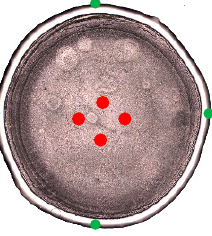
Figure 3. Illustration of the different positions of the Raman acquisition for the limit-of-detection (LOD) evaluation. The green spot corresponds to the measure of concentrated proteins and the red spot corresponds to the measure of excipients.